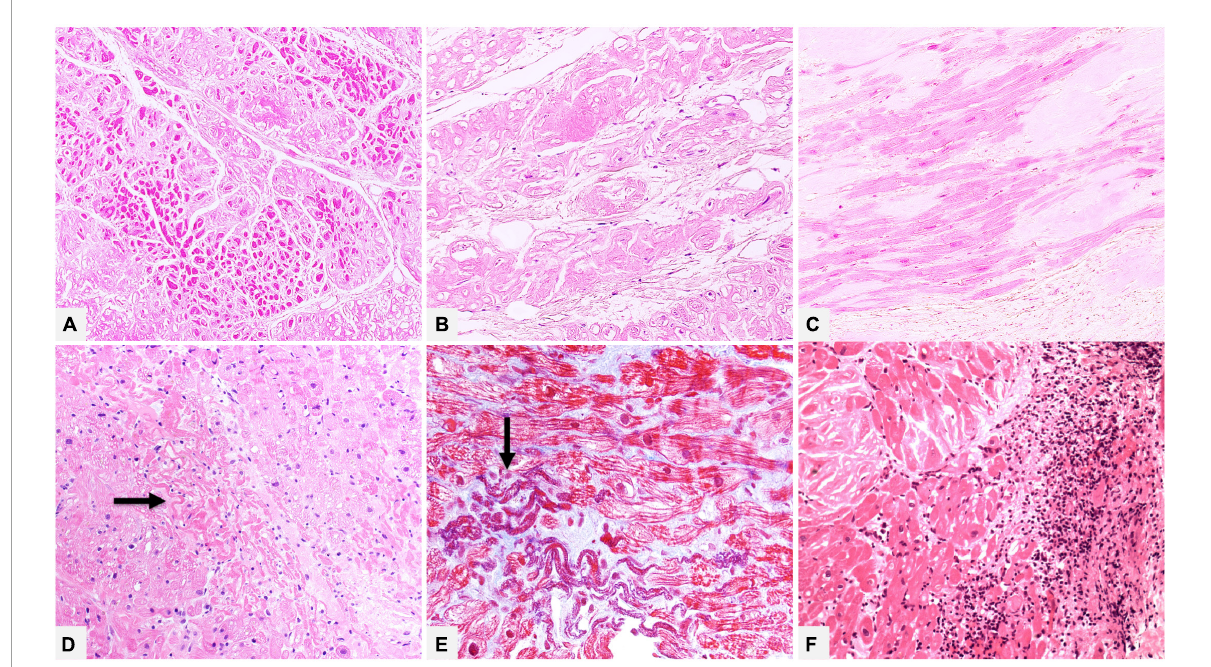
FIGURE5 (A–C) Native heart of a 61 year-old male patient transplanted for ATTRwt. In the myocardial interstitium we can see amyloid deposits and morphologic chronic remodeling of cardiomyocytes, which show attenuation/atrophy ( A , Hematoxylin-Eosin 100 × ), cytoplasmic vacuolization ( B , Hematoxylin-Eosin 200 × ) or reactive hypertrophy ( C , Hematoxylin-Eosin 200 × ). (D,E) Endomyocardial biopsy of a 55 year-old male patient with AL, where deposits prevalently involve vessel wall (not shown). There are foci of recent ischemic-like myocardial damage (thinned and wavy cardiomyocytes, hypereosinophilic and/or coagulated cytoplasm) (arrows). (D) Hematoxylin-Eosin 200 × . (E) Azan Mallory trichrome 400 × . Panel (F) shows an endomyocardial biopsy of a patient affected by ATTRv with extensive myocardial interstitial inflammatory infiltrates, mainly consisting of lymphocytes, associated with amyloid deposits and myocyte inflammatory damage (Hematoxylin-Eosin, 200 ×